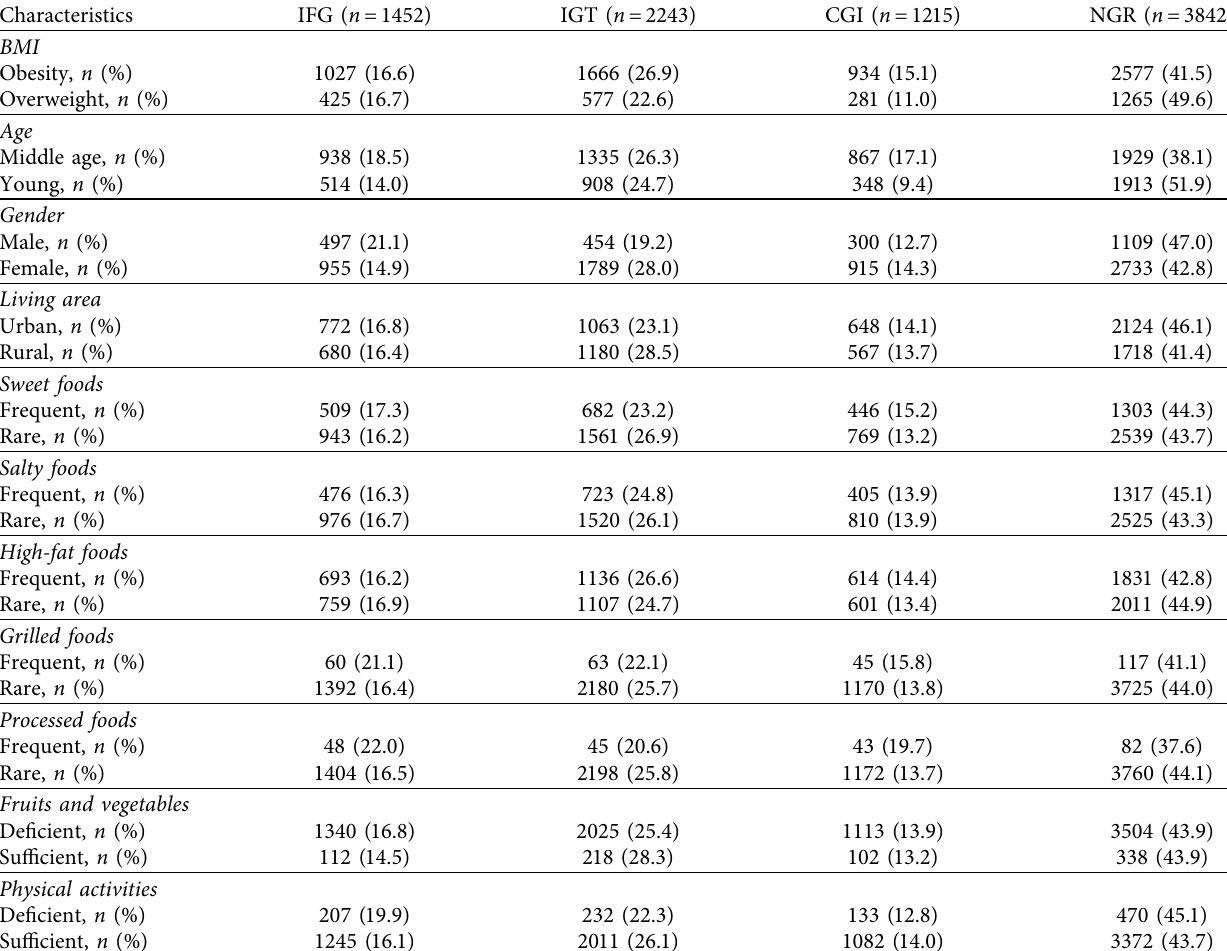
Table 1: Characteristics of the study participants ( n �